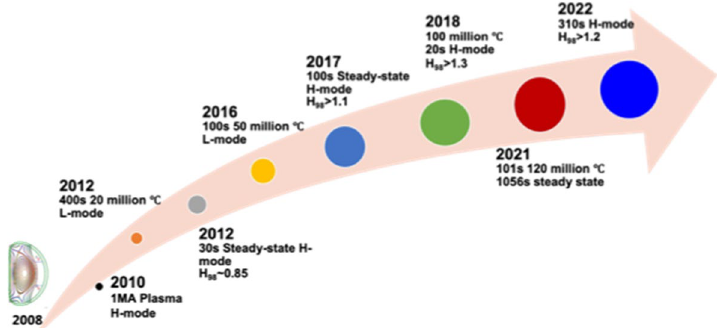
Fig. 8 Experiment milestones of long pulse divertor operation in EAST